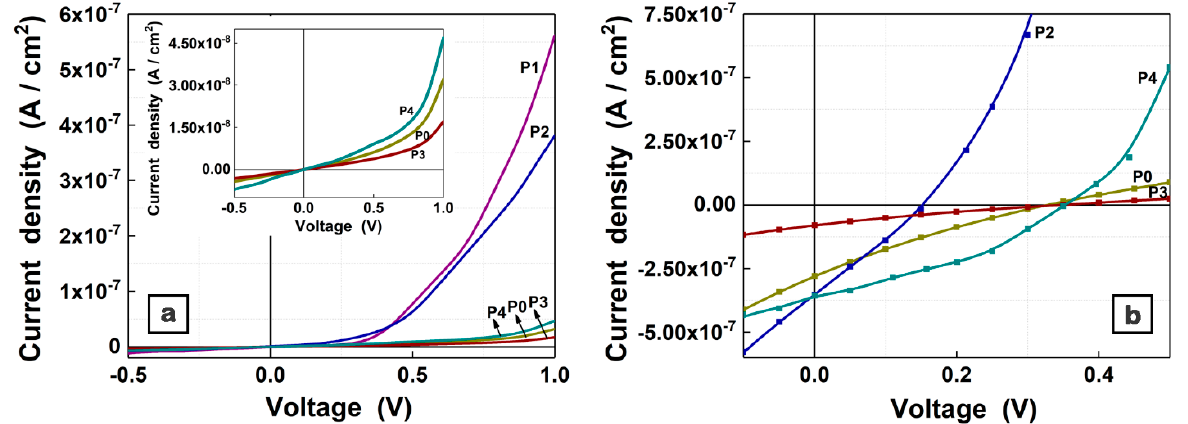
Figure 8. J-V characteristics in dark ( a ) and under illumination ( b ) in A.M. 1.5 conditions of the